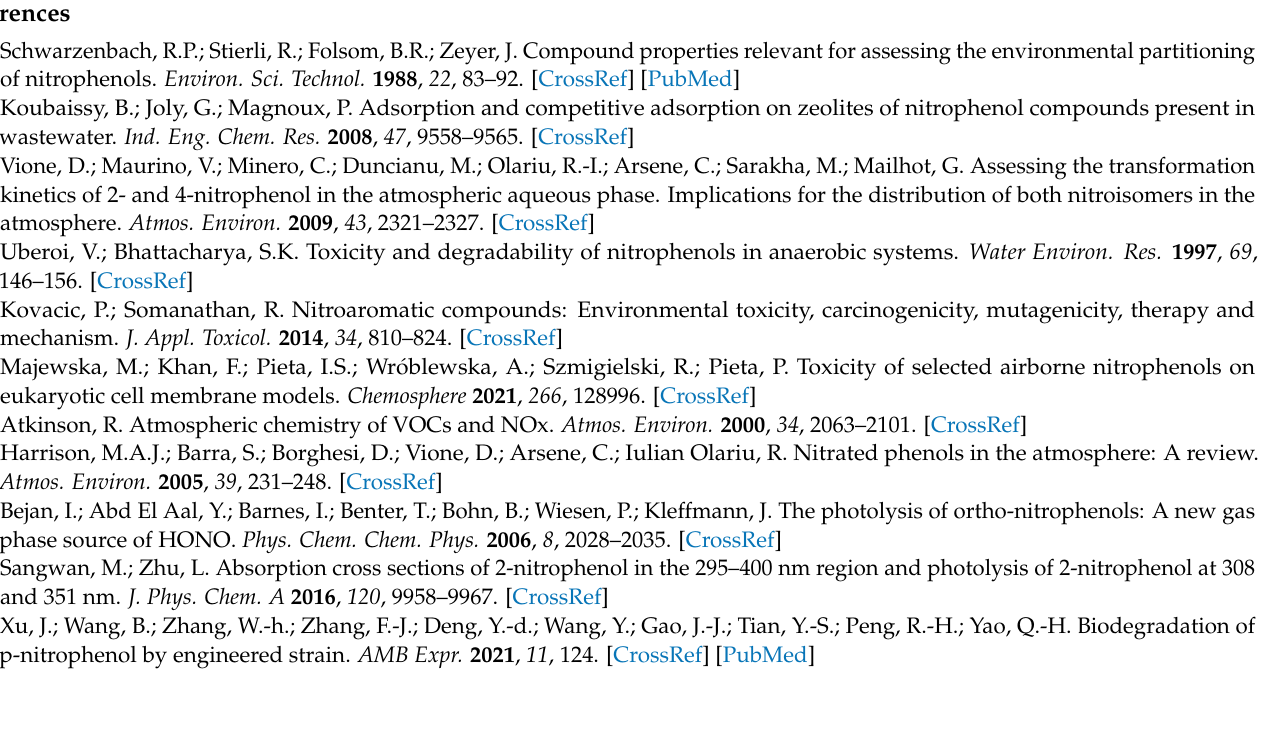
of 2-nitrophenolate (2NP − ) in water; Table S4: Calculated ground-state Raman and experimental FSRS peak frequencies with vibrational normal-mode assignments of 3-nitrophenolate (3NP − ) in water; Table S5: Calculated ground-state Raman and experimental FSRS peak frequencies with vibrational normal-mode assignments of 4-nitrophenolate (4NP − ) in water; Table S6: Calculated ground-state Raman and experimental FSRS peak frequencies with vibrational normal-mode assign- ments of 2-nitrophenol (2NP) in water; Table S7: Calculated ground-state Raman and experimental Table S8: Calculated ground-state Raman and experimental FSRS peak frequencies with vibrational normal-mode assignments of 4-nitrophenol (4NP) in water; and Supplementary References